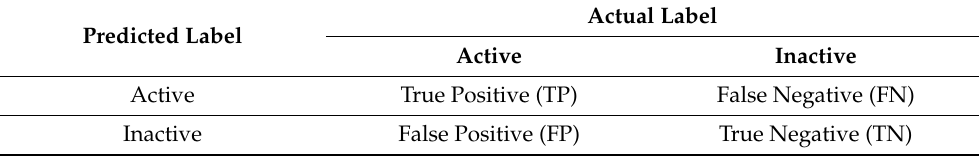
Table 1. Confusion matrix